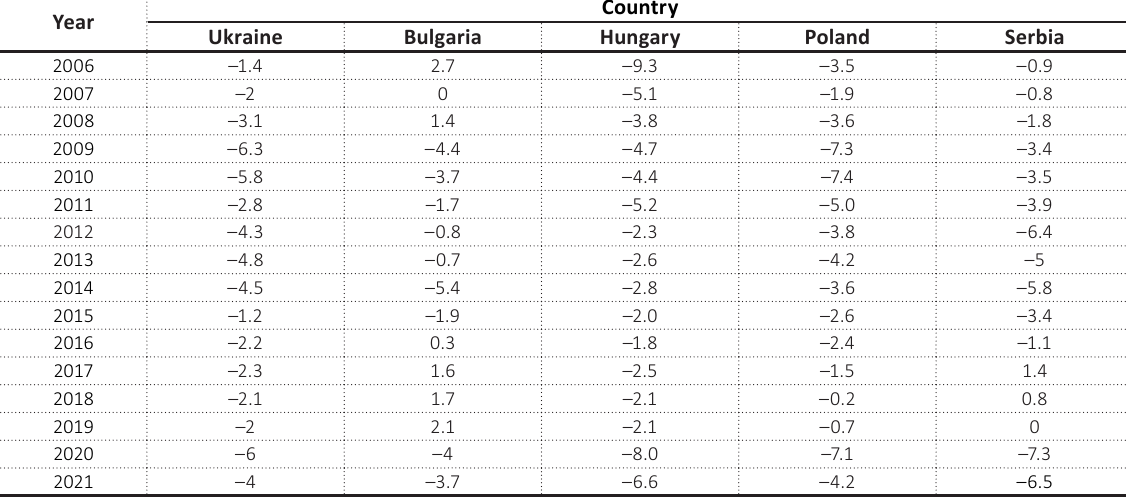
Source: IMF WEO (2022).